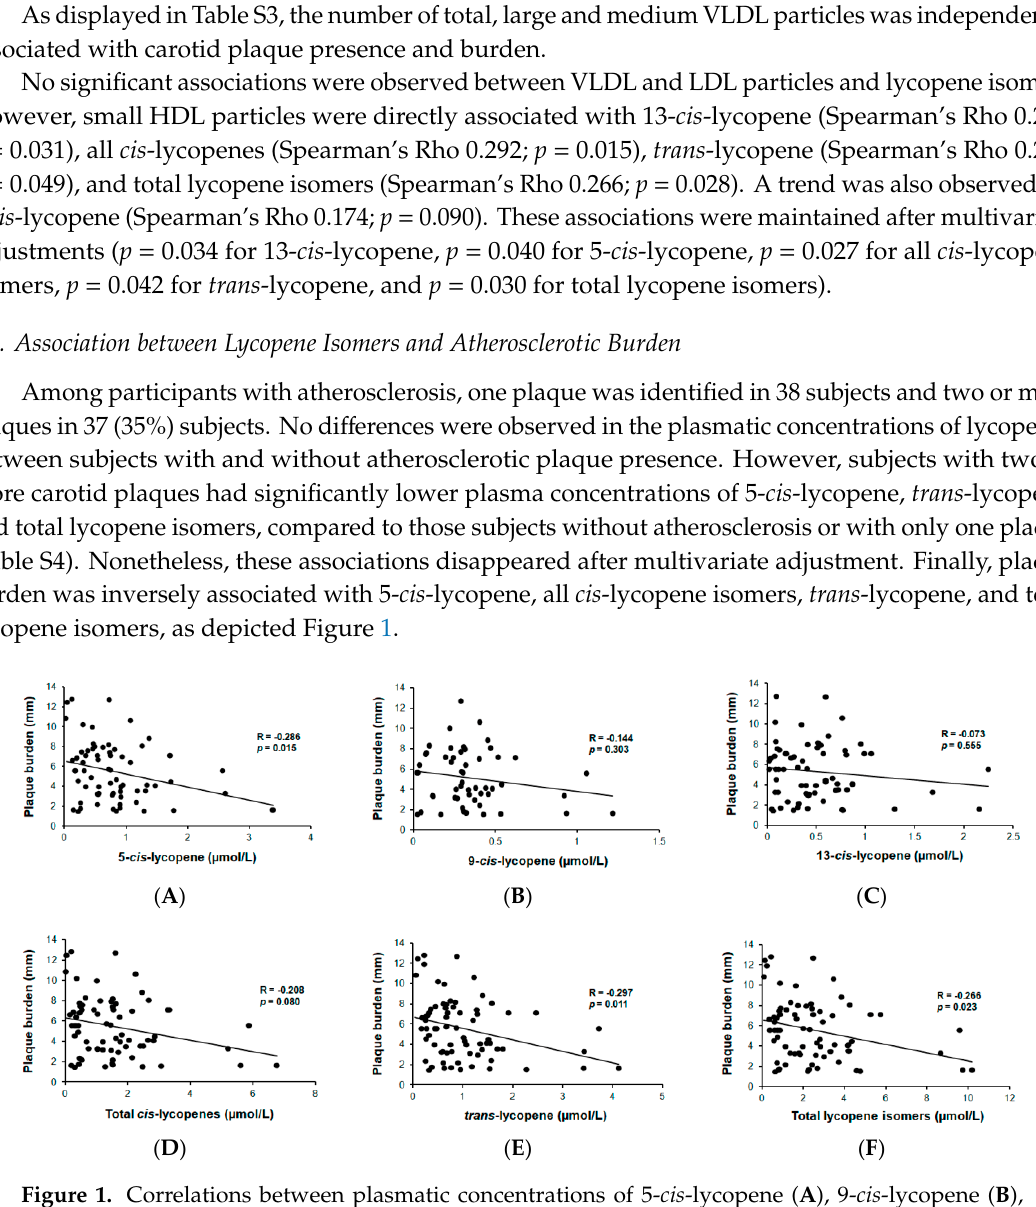
Figure 1. Correlations between plasmatic concentrations of 5- cis -lycopene ( A ), 9- cis -lycopene ( B ), 13- cis -lycopene ( C ), total cis -lycopenes ( D ), trans -lycopene ( E ), total lycopene isomers ( F ) and plaque burden. R (Rho coefficient) and p value from the Spearman’s correlation analyses. Plaque burden was calculated as the sum of maximum heights of all plaques. Data from n = 75 participants. These associations remained after multivariate adjustments except for all cis -lycopene isomers, as shown in Table